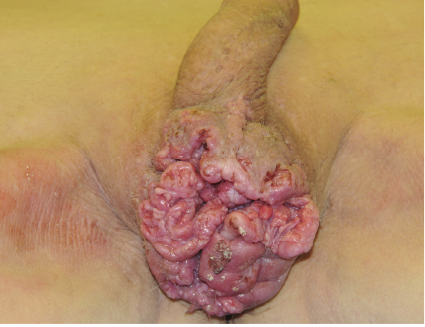
Figure 1: Late presentation of scrotal lesion, initially managed as scrotal abscess.